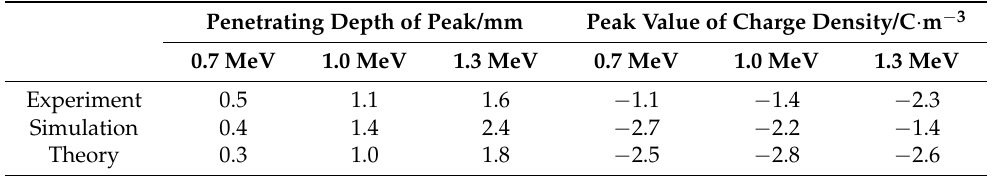
Figure 9. Evaluation results of internal charging under different electron energy radiation: ( a ) experimental measurement; ( b ) simulation calculation; ( c ) theoretical calculation. Table 2. Comparison of experimental and calculated results of charge deposition distribution under different energies.